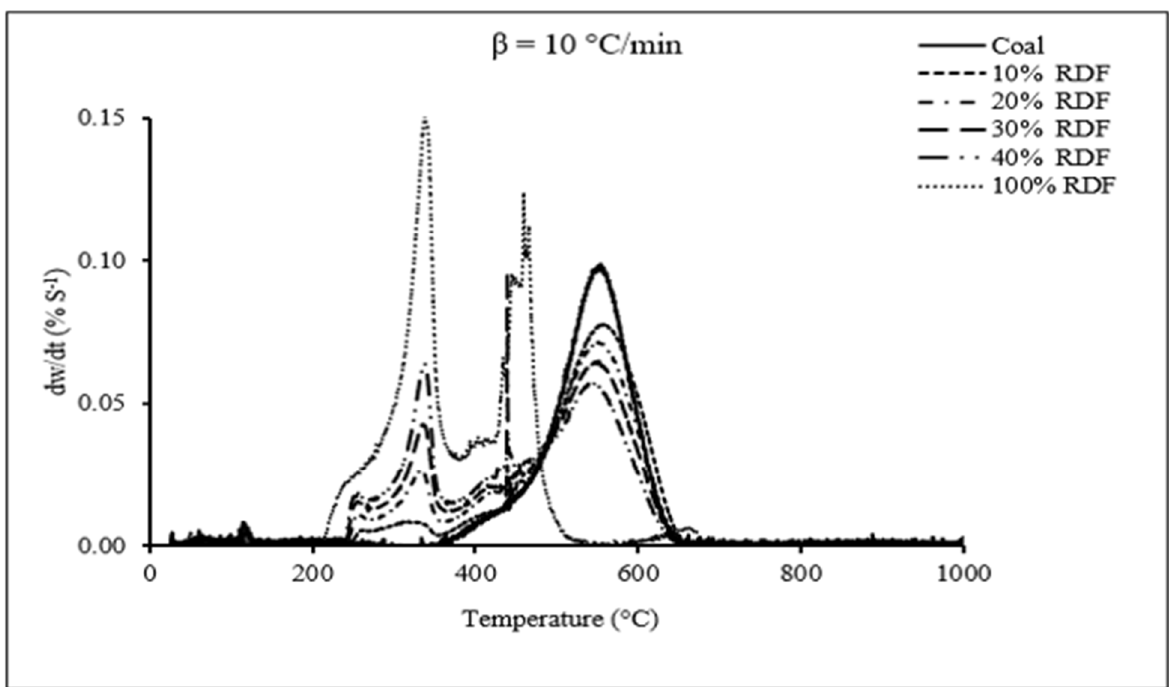
Figure 2. DTG profiles for coal, RDF, and coal/RDF blends for combustion process .